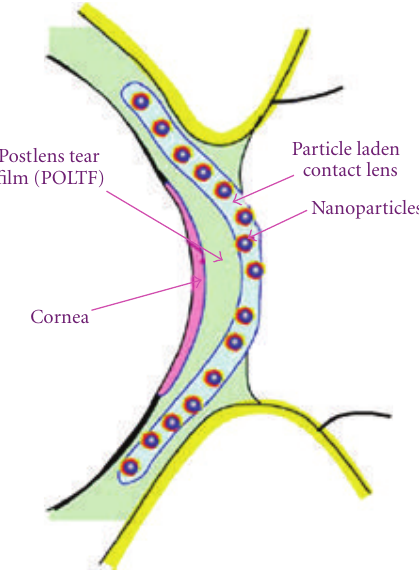
Figure 1: Schematic illustration of the particle-laden lens inserted in the eye [27,